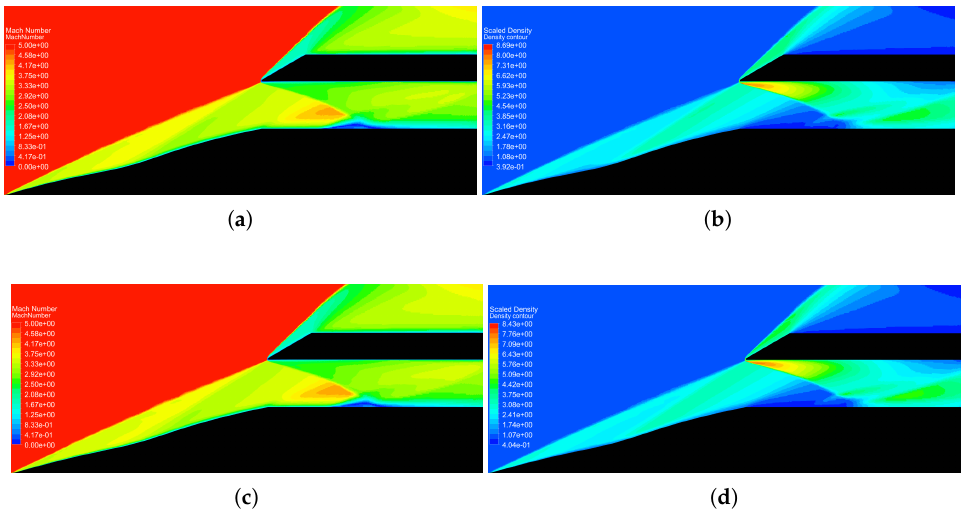
Figure 12. Mach number and scaled density contours for optimized f 1 / f 3 solutions. ( a ) Mach number contour C d —optimum; ( b ) Density contour C d —optimum; ( c ) Mach number contour TPR —optimum; ( d ) Density contour TPR